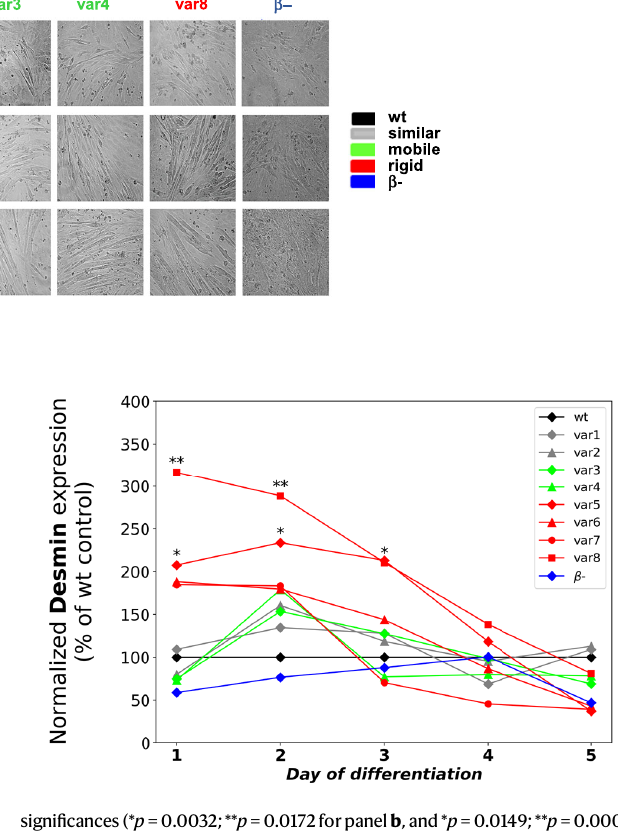
signi fi cances(* p =0.0032;** p =0.0172forpanel b ,and* p =0.0149;** p =0.0002for panel c ) were computed using two-sided student t-test as compared to the wild- type control on the given day of differentiation. b Protein expression of the early differentiation regulator MyoD. Variants with rigid β -domains ( var5 - var8 , red) exhibit higher level of MyoD expression on day 1 and day 2. Signi fi cant deviations ( var5 p =0.0032; var8 p =0.0172) were observed in case of var5 and var8 using two-sided student t-test as compared to the wild-type control on the given day of differentiation. c Protein expression of the late differentiation marker desmin. More rigid β -domain variants ( var5 p =0.0149; var8 p =0.0002, red) signi fi cantly increase desmin expression on days 1 and